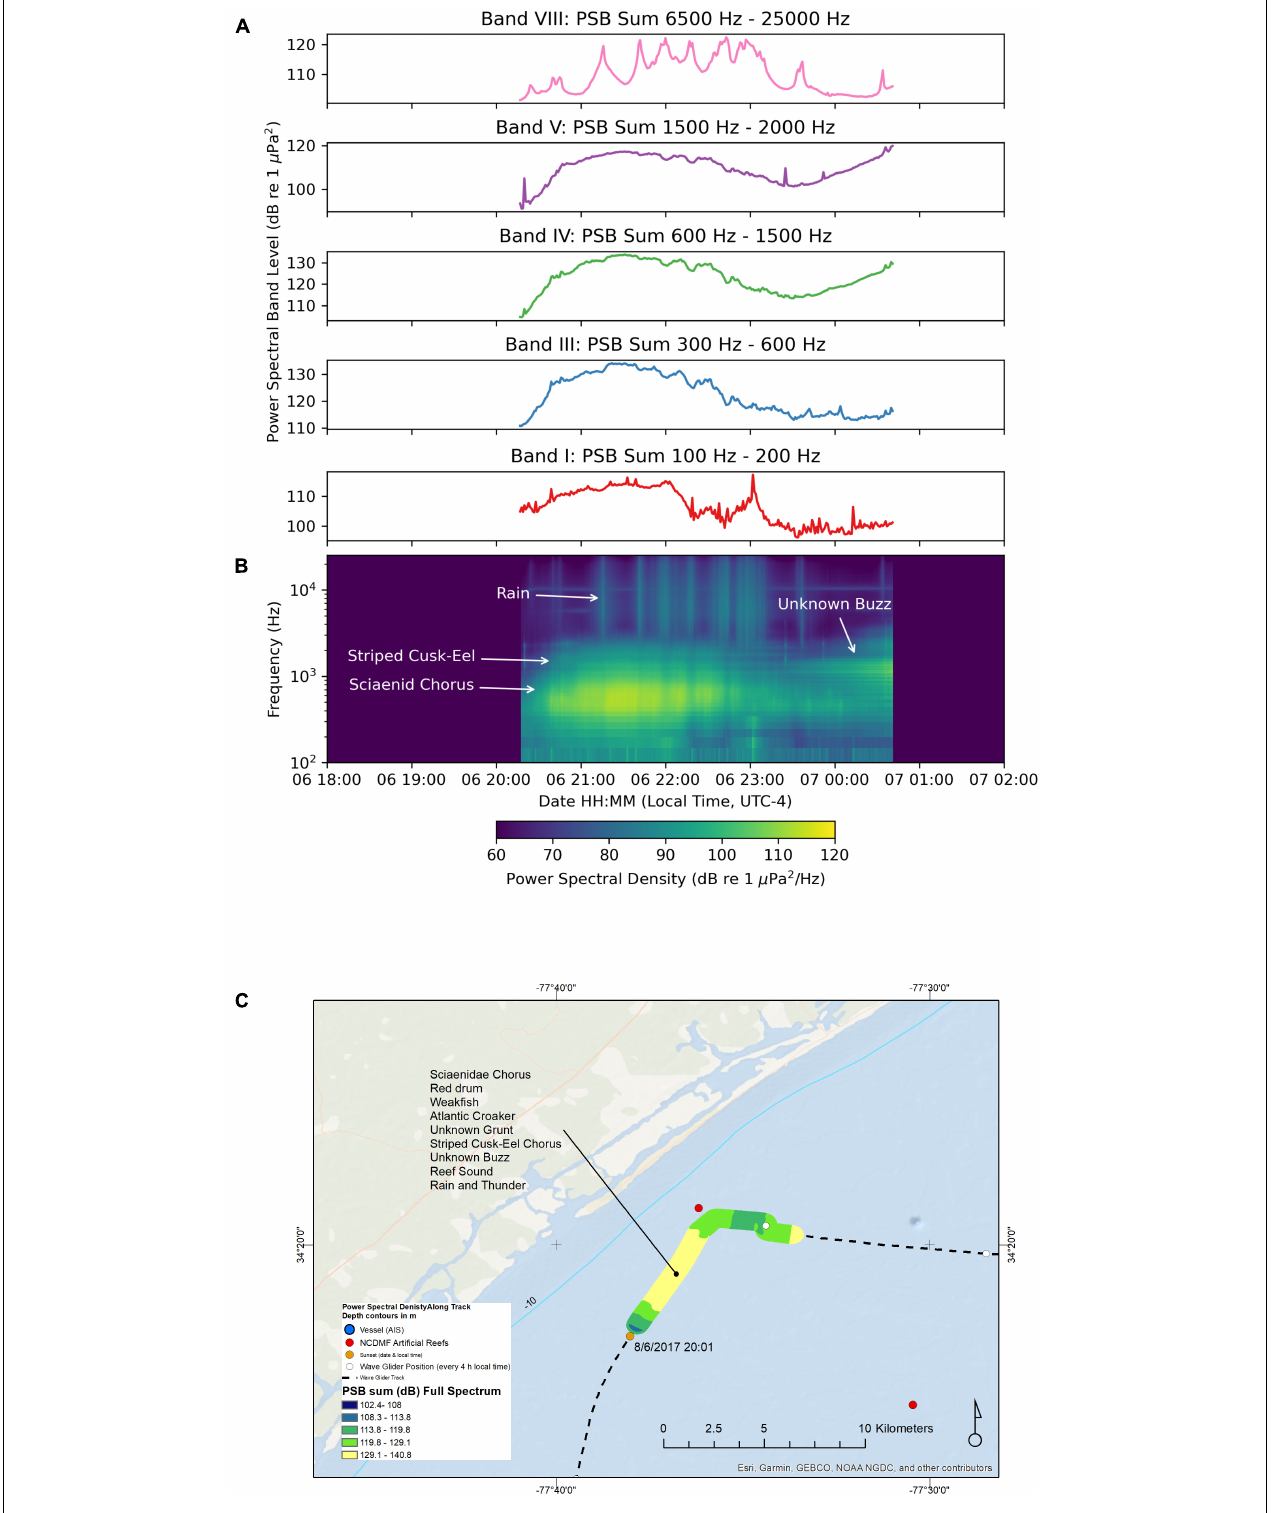
FIGURE 6 | Sound recorded by the wave glider Blackbeard between August-06 18:00 and August-07 02:00. (A) Power spectral band sums for 60 s windows of the recording. (B) Composite spectrogram produced from 60 s average power spectral densities. (C) Map of the path of the wave glider during the recording. The color of the path indicates the full spectrum PSB sum detected at the